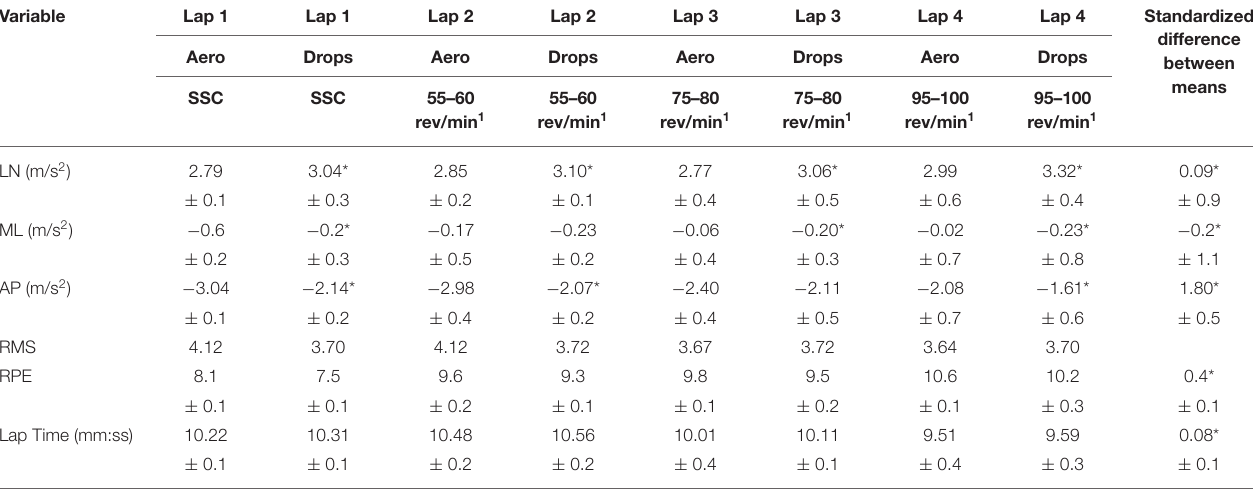
TABLE 3 | Descriptive statistics for the magnitude of mean triaxial torso acceleration in cycling in aero and drops positions across all cadences (in m/s 2 ). Variable